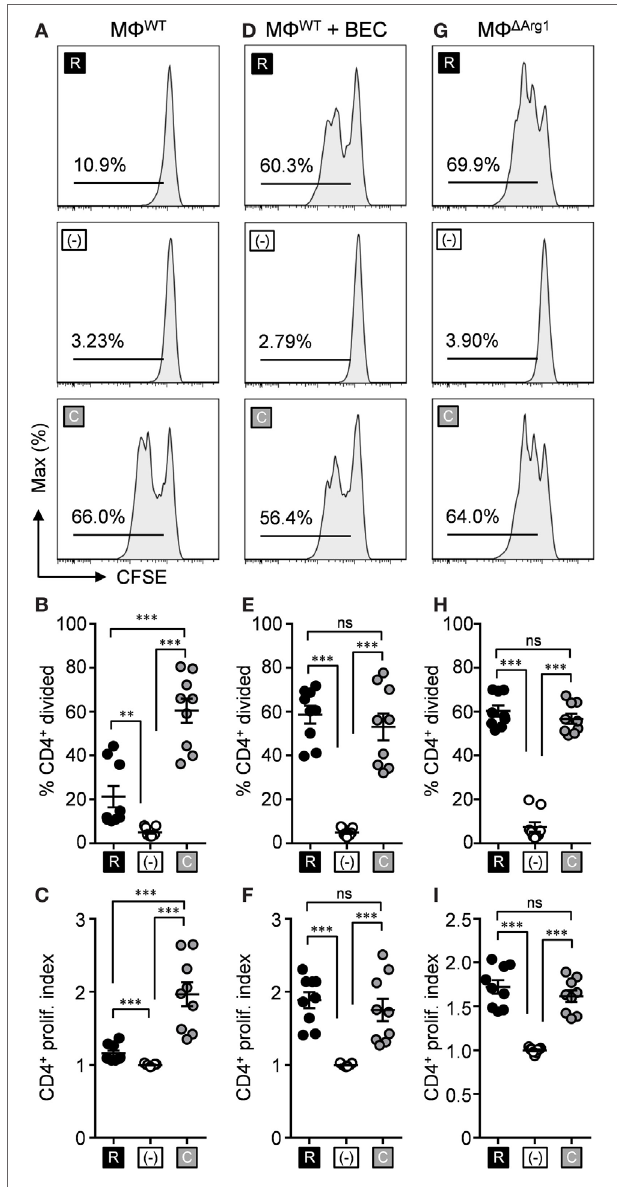
FigUre 3 | l - c itrulline metabolism prevents arginase-mediated suppression of anti-mycobacterial T cells. Carboxyfluorescein succinimidyl ester (CFSE)-labeled lymphocytes from P25 mice were cocultured with HK-BCG- pulsed wild-type macrophages (M Φ WT ) (a–c) , HK-BCG-pulsed wild-type macrophages treated with BEC (D–F) , or HK-BCG-pulsed Arg1 flox/flox ;Tie2-cre macrophages (M Φ Δ Arg1 ) (g–i) . Cocultures were incubated for 72 h with 1 mM l -arginine (black), 1 mM l -citrulline (gray), or neither amino acid (white). CFSE dilution of CD3 + CD4 + T cells was analyzed by flow cytometry. Data are displayed as representative histograms (a,D,g) , mean percent of divided cells (B,e,h) , and proliferation index (c,F,i) as defined in Section “Materials and Methods.” Data are combined from three experiments. Error bars, SEM. ** p < 0.01, *** p < 0.001 according to Student’s t